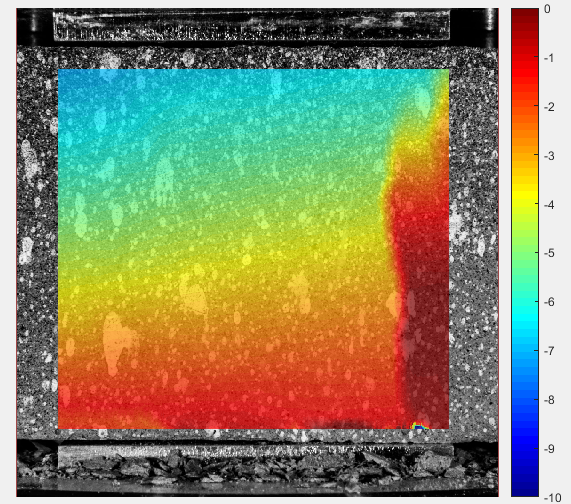
Figure 2. Field of vertical displacement from the Ncorr post